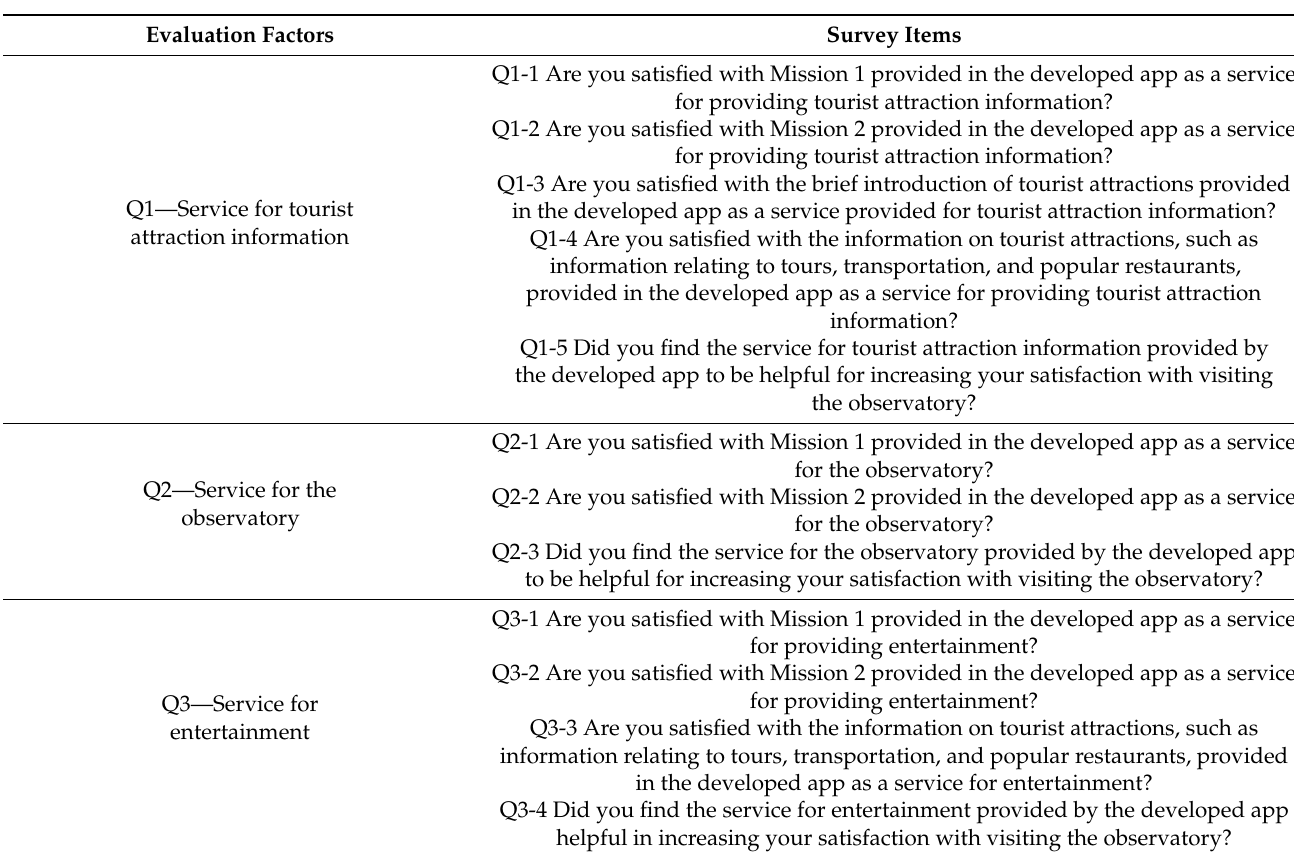
Figure 10. It was found that, depending on the height of the user, the height at which they used their smartphone, and the location of the user, there was a point where the direction and position of the place, as described by the AR object shown to be the actual landmark icon marker, were different from the real place. Therefore, we tried to reduce the error by using the app 1 m away from the average height of the main users and marker [43]. Table 4. Survey questionnaires on the satisfaction of users with using Seoul